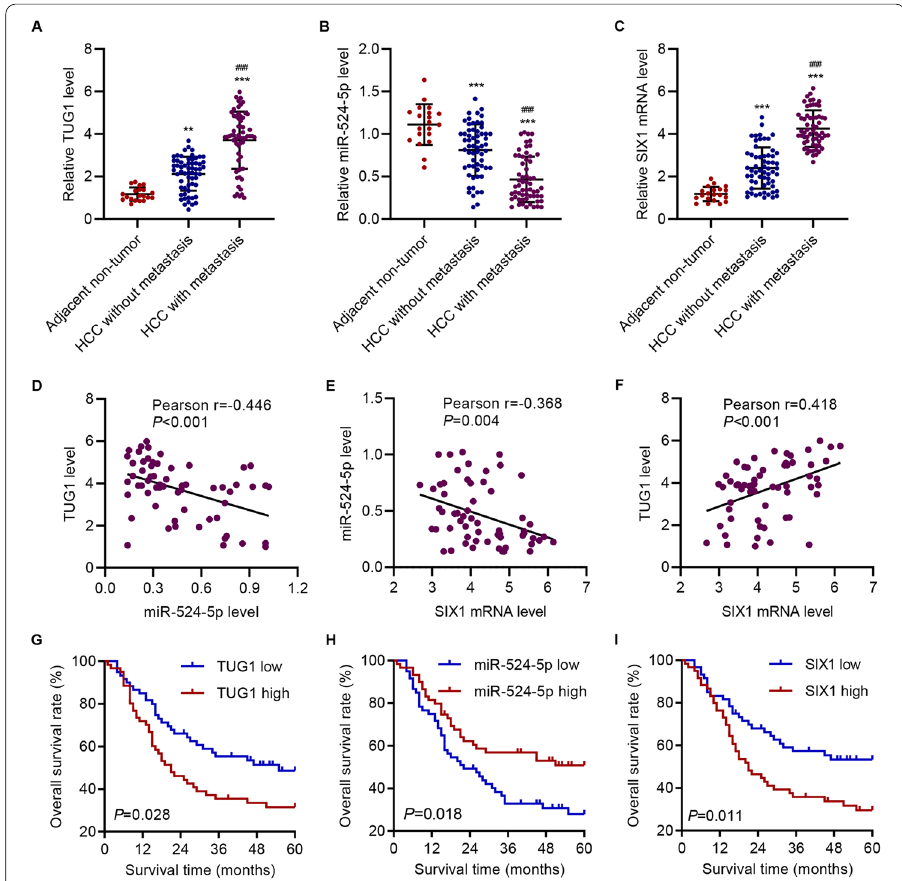
Fig. 6 TUG1 negatively correlated with miR-524-5p and positively correlated with SIX1. qPCR assay of ( A ) TUG1, ( B ) miR-524-5p, and ( C ) SIX1 mRNA levels in adjacent non-tumor (n 20), non-metastatic (n 60), = = and metastatic tumor (n 60) tissues. D – F Pearson correlation analysis among TUG1, miR-524-5p, and SIX1 = mRNA levels in tumor tissues from 60 HCC patients with metastasis. G – I Survival probability of patients with HCC from hospital cohort, in which patients were split by the median value of TUG1, miR-524-5p, and SIX1 mRNA. The data are expressed as the mean SD (n 20 or 60). ** P < 0.01, *** P < 0.001 vs adjacent non-tumor. ± = ### P < 0.001 vs non-metastatic HCC